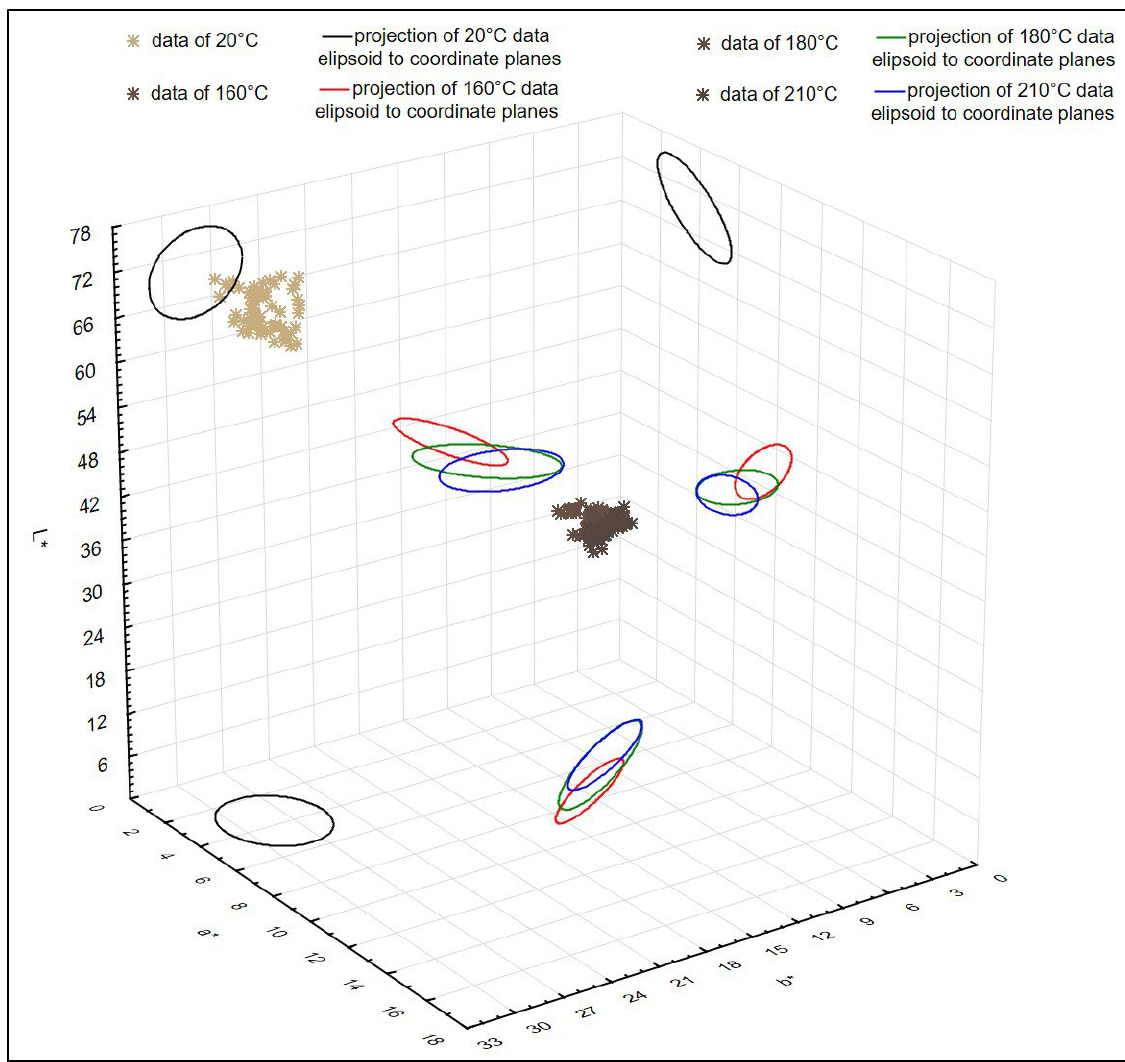
Figure 2. The measured colour data of black locust and their projections to coordinate planes of CIE L*a*b*. Table 2. The averages of black locust colour properties in CIE L*a*b* colour space (mean ± SD).